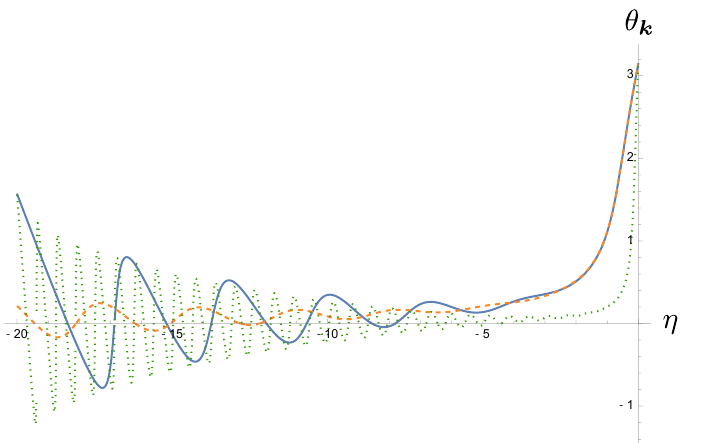
Figure 4. The time variation of the phase θ k in coherence C k = | C k | e i θ k for mode k . The blue solid curve has the initial time is η 0 = − 20 and k = 1, the orange dashed curve η 0 = − 40 and k = 1, and the green dotted curve η 0 = − 20 and k =